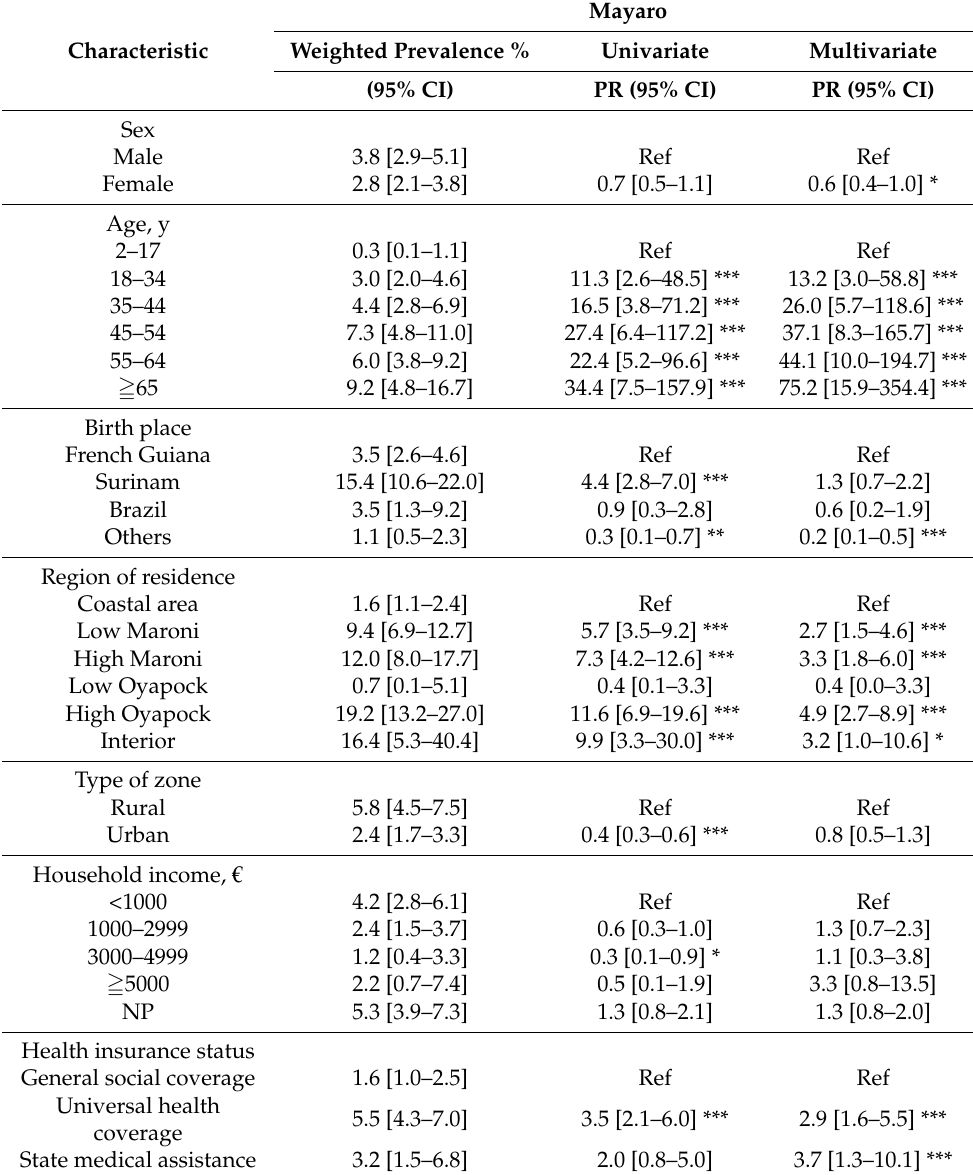
Table 3. Factors associated with MAYV